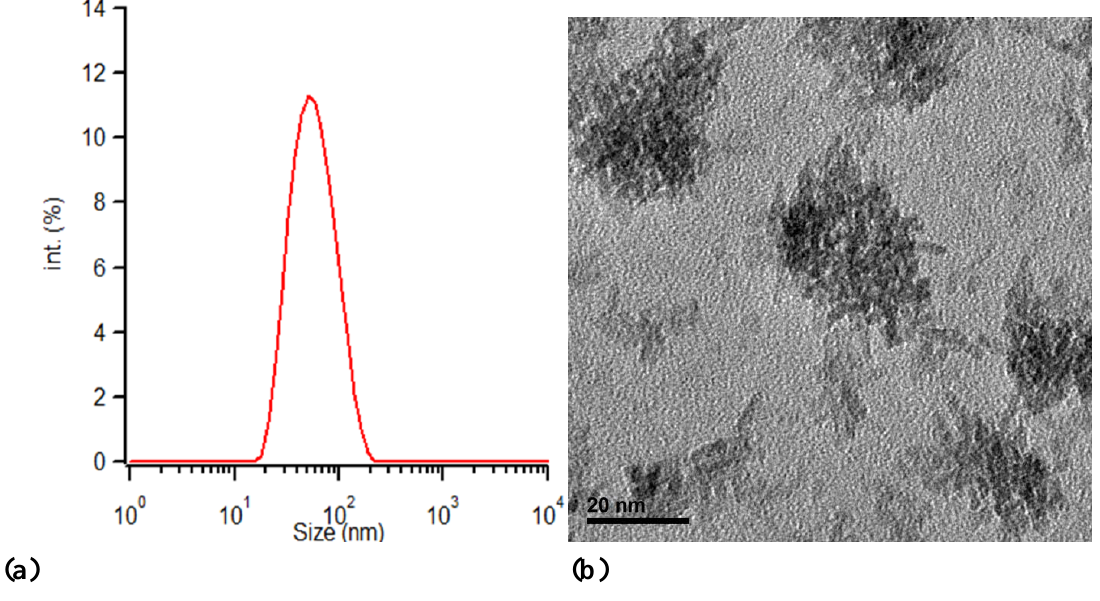
Figure 1. ( a ) The particle size of ZrO particles synthesized by microwave treatment of 2 solution A at 150 °C for 30 min measured by DLS; and ( b ) TEM micrograph of the solution A treated for 30 min at 150